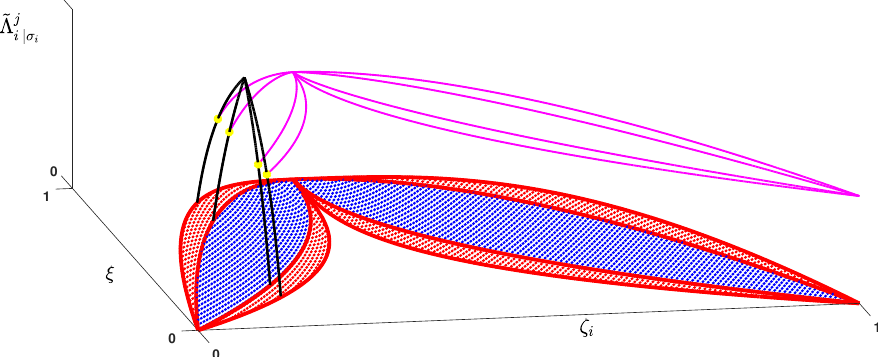
Figure 4. Type-3